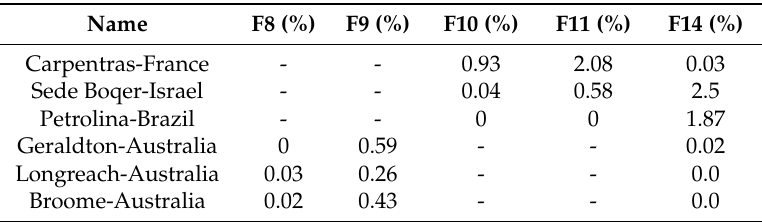
Table 7. The ratio of error flags at validation stations.